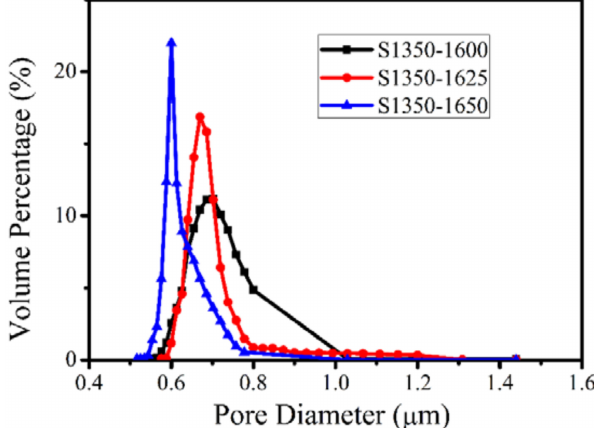
Figure 5. Pore-size distribution of the membranes sintered at various temperatures.